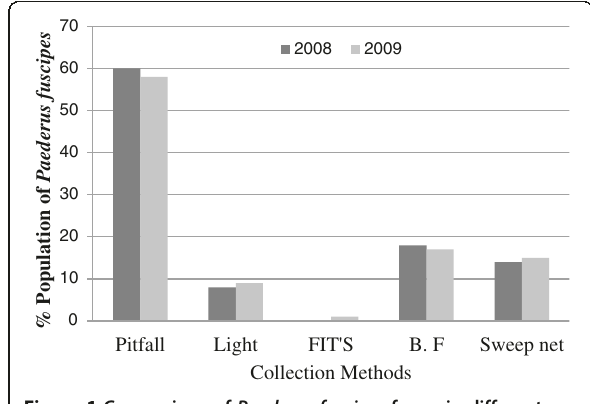
Figure 1 Comparison of Paederus fuscipes fauna in different traps during 2008 and